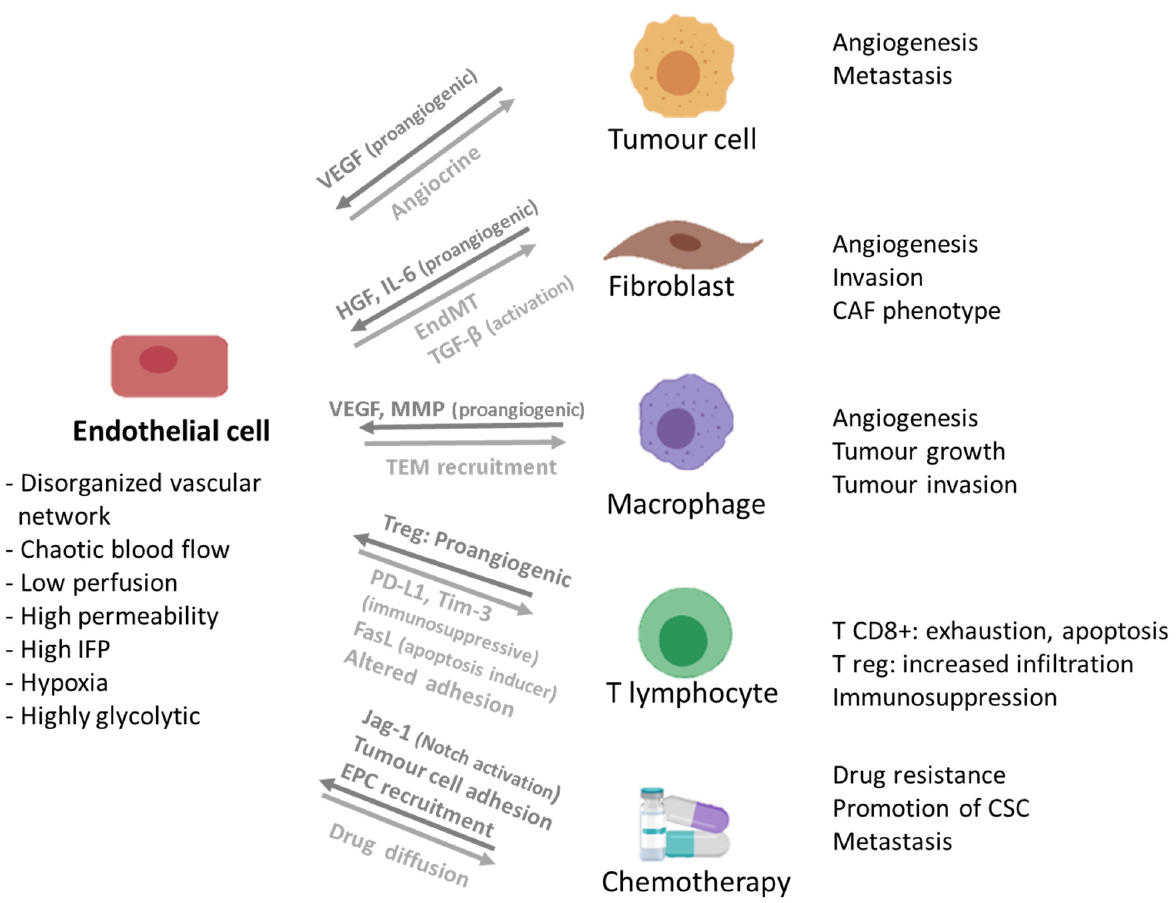
Figure 2. Schematic representation of the characteristics of tumour-associated endothelial cells, their interactions and reciprocal effects on tumour cells and on other non-malignant of the tumour microenvironment, and effects of chemotherapy on them [16,148,150]. Image created with BioRender. CAF: Cancer-associated fibroblast; CSC: Cancer-stem cell; FasL: Fas ligand; EPC: Endothelial progenitor cell; EndMT: Endothelial to mesenchymal transition; HGF: Hepatocyte growth factor; IFP: Interstitial fluid pressure; IL-6: Interleukin 6; Jag-1: Jagged-1; MMP: Matrix metalloproteinase; PD-L1: Programmed death ligand 1; TEM: Tie expressing monocytes; Tim-3: T-cell immunoglobulin and mucin domain-3; TGF- β : Transforming growth factor β ; Treg: Regulatory T cell; VEGF: Vascular endothelial growth